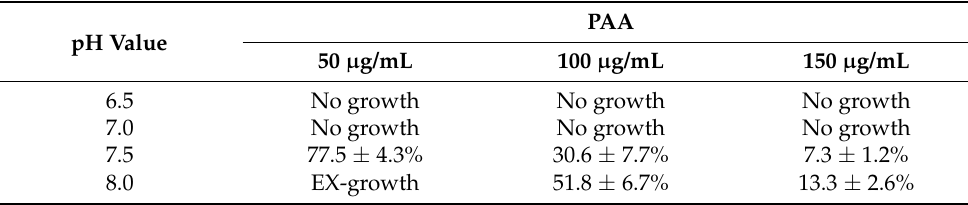
Table 1. The percentage of the area (%) with intrafibrillar HAP nanocrystals of collagen films in different conditions. “EX-growth” means the extrafibrillar growth of